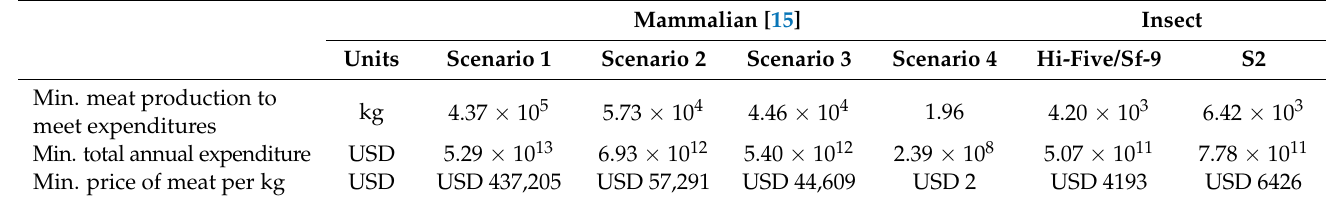
Table 7. Outcome values relating to finances produced by the model for four mammalian scenarios proposed in the Risner et al. paper compared to outcomes for Hi-Five/Sf-9 and S2 insect cells [15].